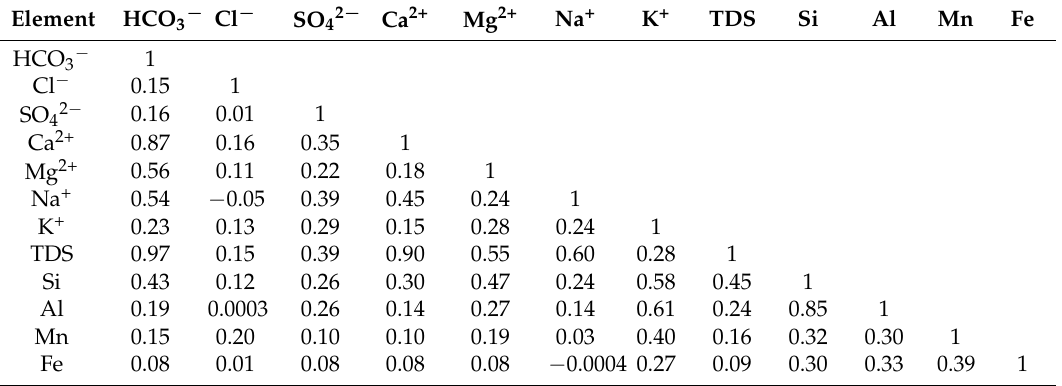
Table 3. Correlation matrix for water chemical composition in the study area ( n = 107, p = 0.05, R = 0.5).